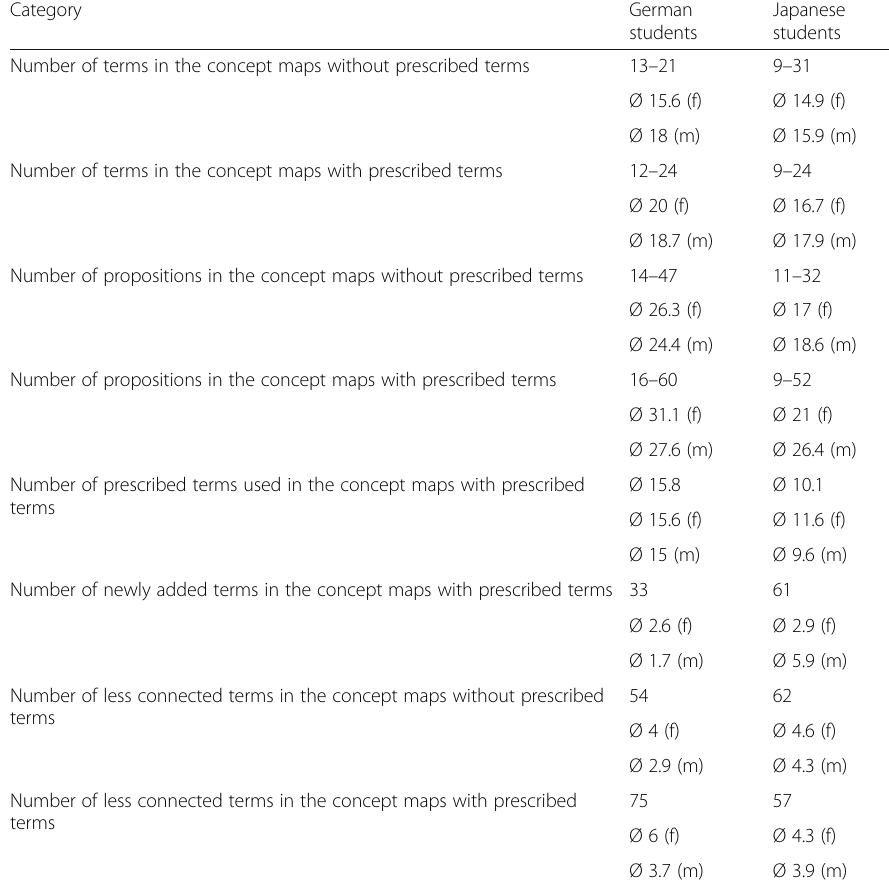
Table 2 Numbers of different factors in the concept maps, differentiated according to German and Japanese and female (f) and male (m) students (Ø means “ in average ” ) Category German